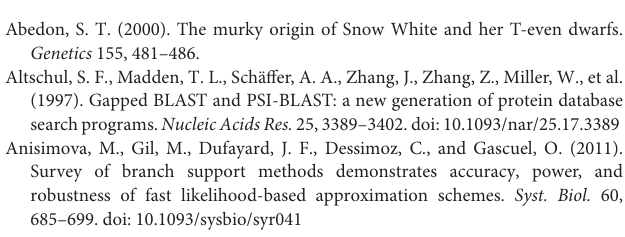
Supplementary Data Sheet 4 | Characteristics of Tevenvirinae